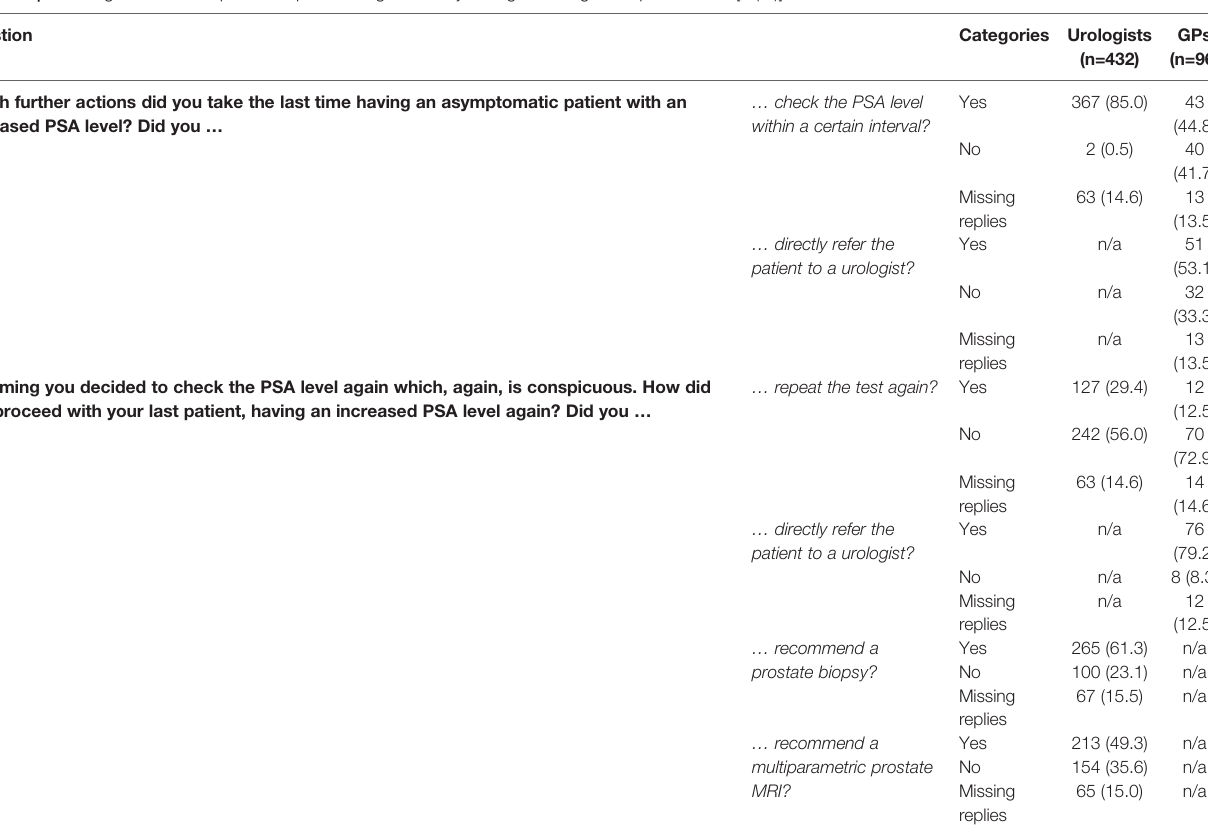
TABLE 7 | Handling an increased prostate-speci fi c antigen level by urologists and general practitioners [n (%)]. Question Categories Urologists